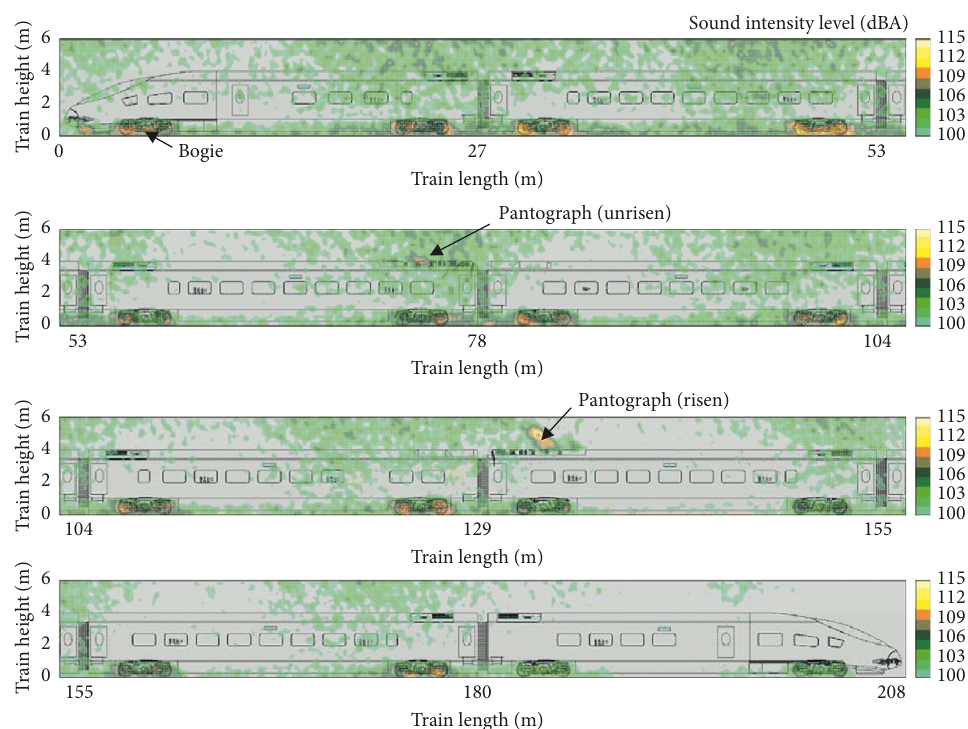
Figure 6: Exterior noise source distribution of the high-speed train running at 350km/h (500–5000 Hz).